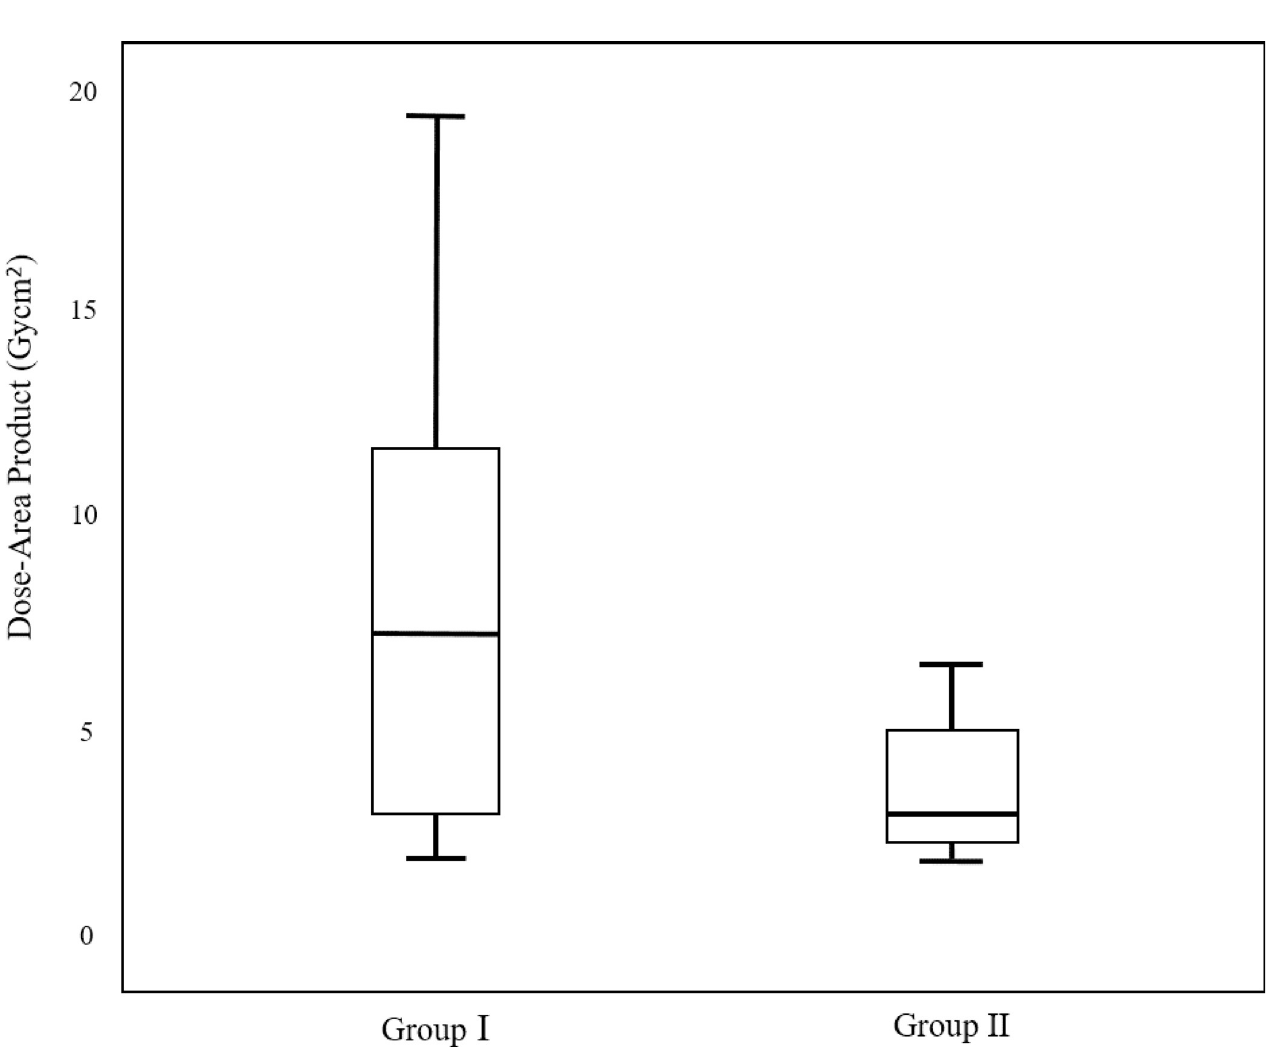
Fig 5. A box and whisker plot comparing the dose-area product (DAP) of groups I and II. The mean DAP was 7.9 ± 4.1 Gy cm 2 in group I and 5.4 ± 1.9 Gy cm 2 in group II ( p = 0.016).